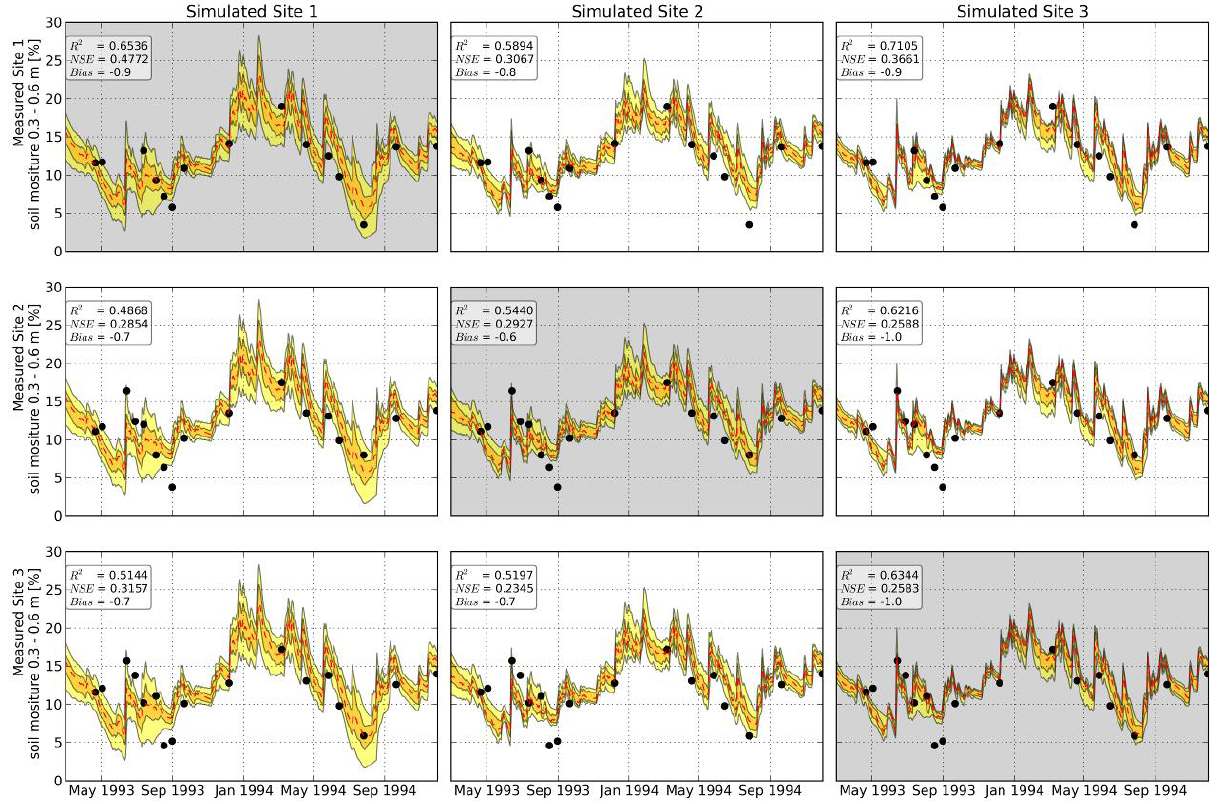
Fig. 5. Cross validation of soil moisture prediction with uncertainty boundaries. Grey-shaded sites are calibrated. Black dots are observed values, and the red dashed line is the median of the behavioural boundary condition (NSE > 0, bias < ± 10% soil moisture and R 2 > 0 . 3). The yellow area is the 95% probability range of the simulation, and the orange area the 50% probability range. Figure 5. Cross-validation of soil moisture prediction with uncertainty boundaries. Grey 3 shaded sites are calibrated. Black dots are observed values, red dashed line is the median of 4 t base and root growth. Medians shown as red lines in the box plots indicate optimal parameter settings for the constrained the behavioural boundary condition (NSE>0, bias<±10% soil moisture and R²>0.3). The 5 parameters. They are located more or less at the same posi- tion for the four constrained parameters, while this position yellow area is the 95% probability range of the simulation, the orange area the 50% 6 varies throughout the sites for the other parameters. We con- clude that in further applications of CMF–PMF, ranges for probability range. 7 the constrained parameters as given in Table 1 can be sub- stantially reduced to obtain improved model runs. One could also consider fixing the parameter to the median and exclud- ing them from further